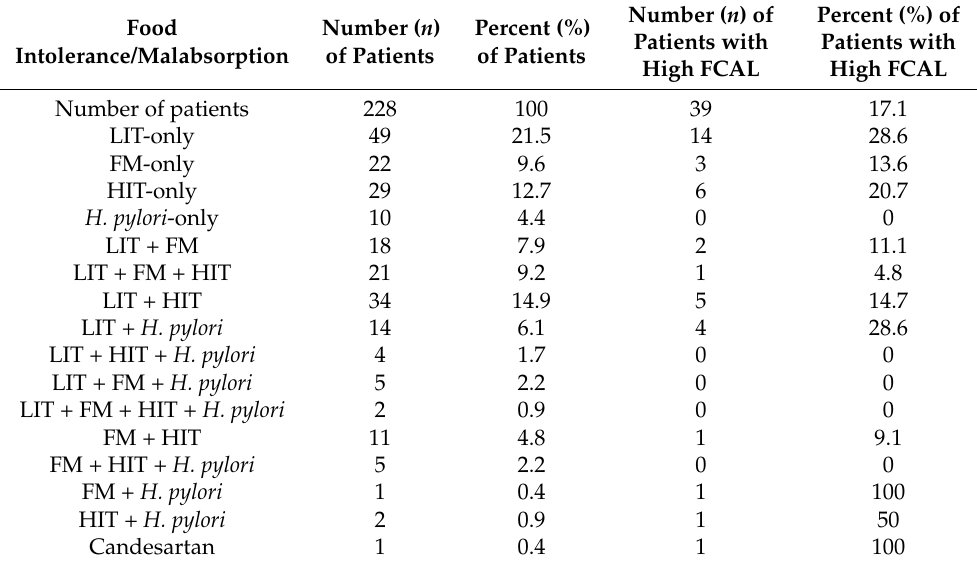
Table 1. FCAL determined in 228 patients with food intolerance/malabsorption and/or H. pylori . Food Number ( n ) Percent Intolerance/Malabsorption of Patients